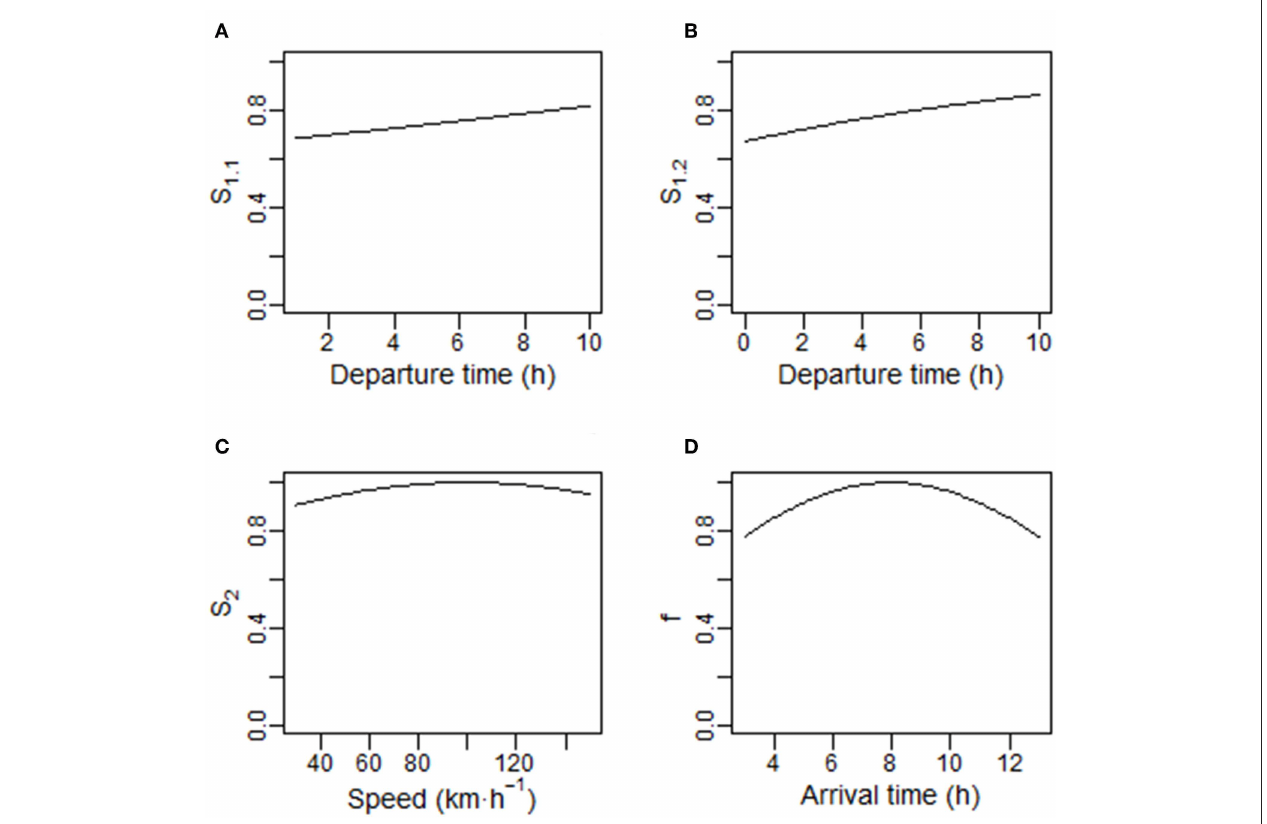
FIGURE 1 | Components of the fitness function used in the commuting model. (A,B) Show the probability of avoiding weather-related delay events ( S 1.1 or S 1.2 ) as a function of departure time ( t 0 in hours). In (A) , S 1.1 = exp(–[ C 0 – α 1.1 t 0 ] · d ); in (B) , S 1.2 = exp( − [ C 0 · exp(– α 1.2 t 0 )] · d ); C 0 = 0.002, α 1.1 = 0.0001, α 1.2 = 0.1, and d = 200km. (C) Shows the probability of avoiding delay events ( S 2 ) as a function of speed (km · h − 1 ); S 2 = exp( − α 2 [( v – v lim ) 2 ] · d ); α 2 = 0.0000001, v lim = 100 km · h − 1 . (D) Shows the fitness benefits accrued at arrival ( f ) as a function of arrival time t 1 ; f 1 = exp( − α 3 · ([ t 1 − τ ] 2 ); α 3 = 0.01 and τ = 8h.